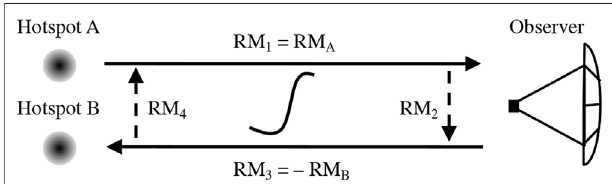
FIGURE 5 | Differential Faraday-rotation measurement geometry for a backgroundradiosourcethatprovidestwoLOS(solidarrows):HotspotAand Hotspot B. The dashed arrows represent the two LOS (with negligible RM) necessary to complete the “ rotation-measure Amperian loop. ” The curved line enclosed by the loop represents a coronal current detected with this measurement. This appears as Figure 1 in Kooi and Kaplan (2020), ©Springer, reproduced with